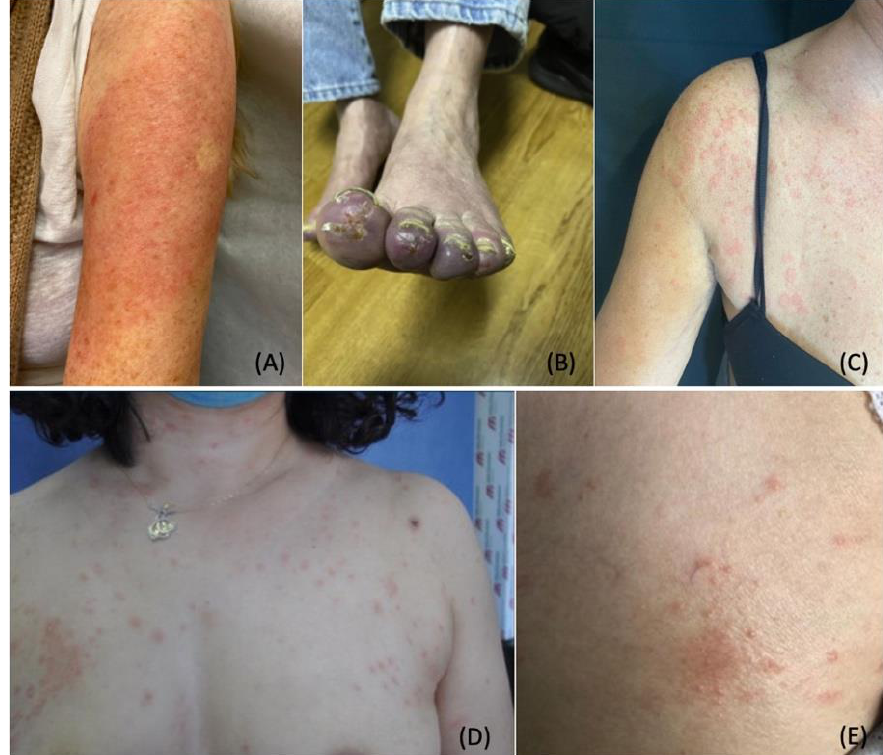
Figure 4. Cutaneous Manifestations Associated with COVID-19 Vaccination. ( A ). Pruritic and erythematous rash was observed on the left arm of a 74-year-old woman eight days following the inoculation of the Moderna vaccine. ( B ). Pernio/chilblains-like lesion of the toes observed in a 76-year-old man one week after receiving the second dose of the Moderna vaccine. ( C ). Urticarial wheals on the trunk of a 48-year-old woman three hours after receiving the second dose of the Oxford-AstraZeneca vaccine. ( D , E ). Oval salmon-colored plaques on the trunk and herald patch on the right breast of a 45-year-old woman four days after receiving the first dose of the CoronaVac vaccine. Photo credit is acknowledged to the following original reports: Nancy Wei [180], John M. Kelso [181], Enes Ya˘gız Akda¸s [184],